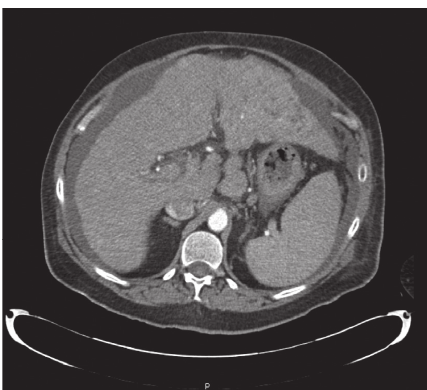
Figure 1: CT liver mass protocol with IV contrast showing evidence of cirrhosis with features of portal hypertension, an ill-defined infiltrative mass in left hepatic lobe suggestive of infiltrative HCC, hypoattenuating lesions in the right hepatic lobe, and periportal lymphadenopathy.